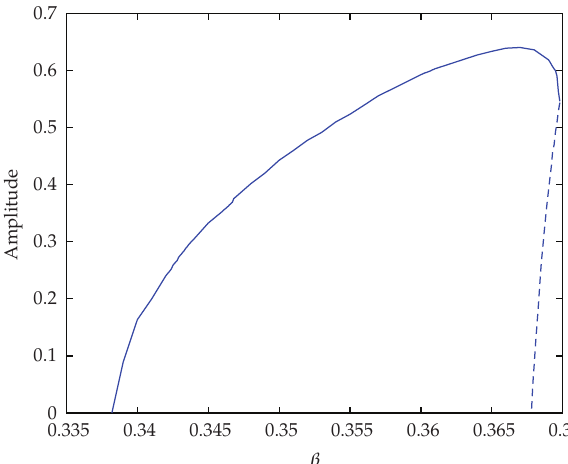
Figure 3: The amplitude of the limit cycles of B (cid:5) t (cid:6) formed at successive values of β for fixed N 0 (cid:7) 2. Here α (cid:7) 0 . 4, γ (cid:7) 1 . 2, δ (cid:7) 0 . 4, η (cid:7) 0 . 01, c b 0 (cid:7) 0 . 1, c p 0 (cid:7) 0 . 1, μ (cid:7) 0 .